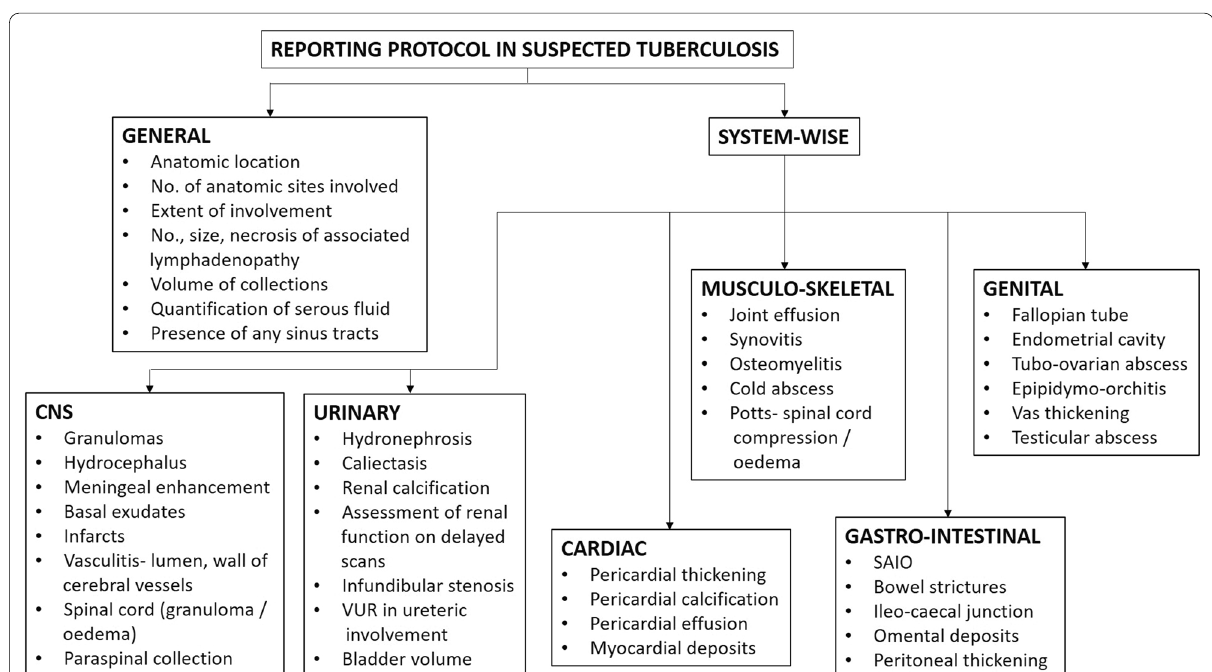
Fig. 21 Flow chart showing general and system-wise reporting protocol in suspected tuberculosis; VUR vesico-ureteric reflux, SAIO subacute intestinal